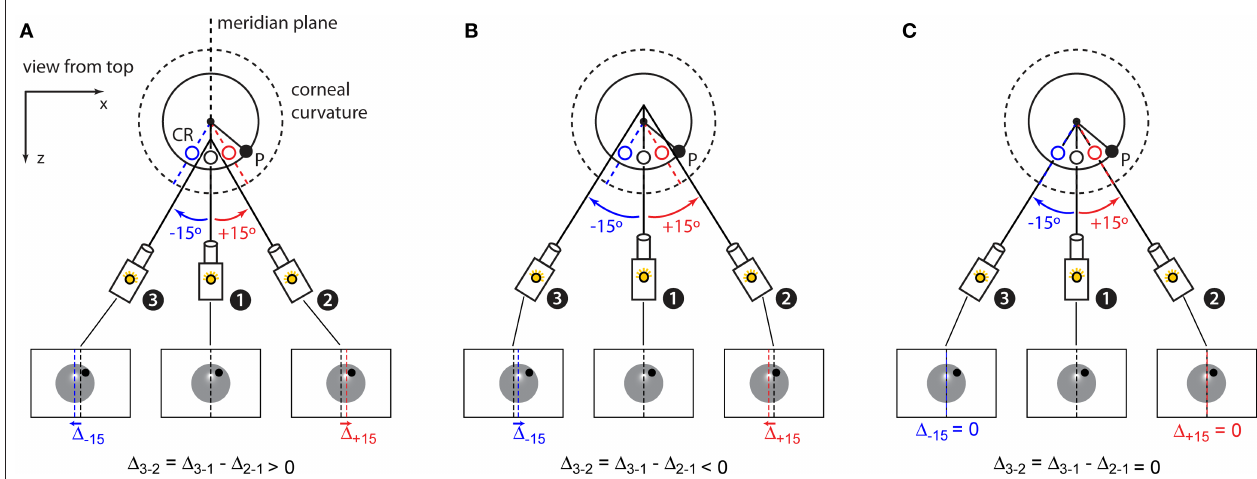
red) and negative (clockwise, blue) pseudo-rotations result in a rightward and leftward displacements of the CR respectively. Therefore, the difference ( ∆ ) 3-2 between the displacement of the CR produced by the positive (red arrow) and negative (blue arrow) camera rotations will be positive. (B) When the camera is rotated about a virtual point (along its optic axis) behind the center of the corneal curvature the CR will be displaced medially and ∆ will be negative. (C) If the 3-2 camera rotates about a virtual point that is aligned to the center of the corneal curvature both the right (red arrow) and left (blue arrow) 15 ° rotations will produce no displacement of the CR and ∆ will be 3-2